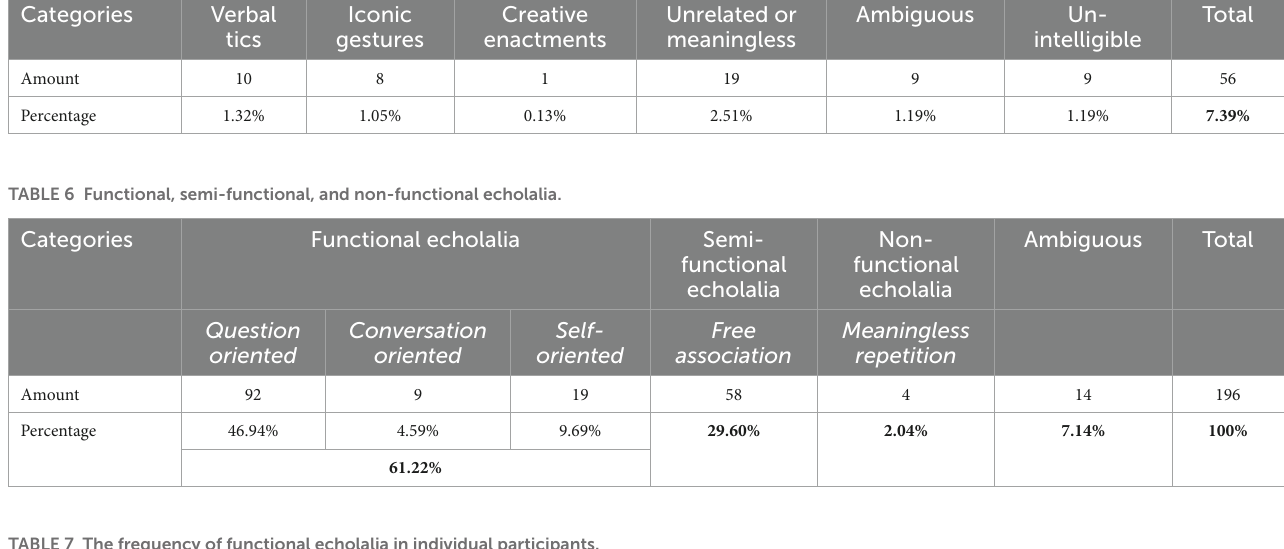
TABLE 7 The frequency of functional echolalia in individual participants.